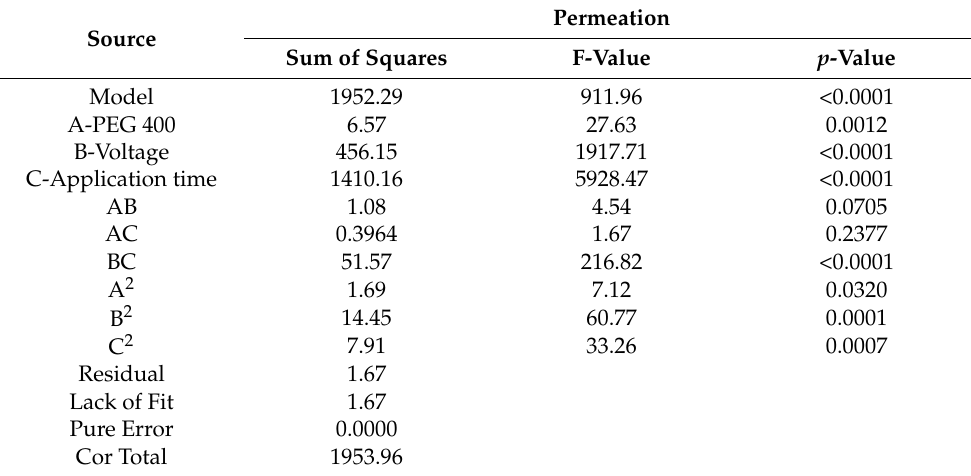
Table 4. The ANOVA data generated through software from the quadratic model on trans-nail drug